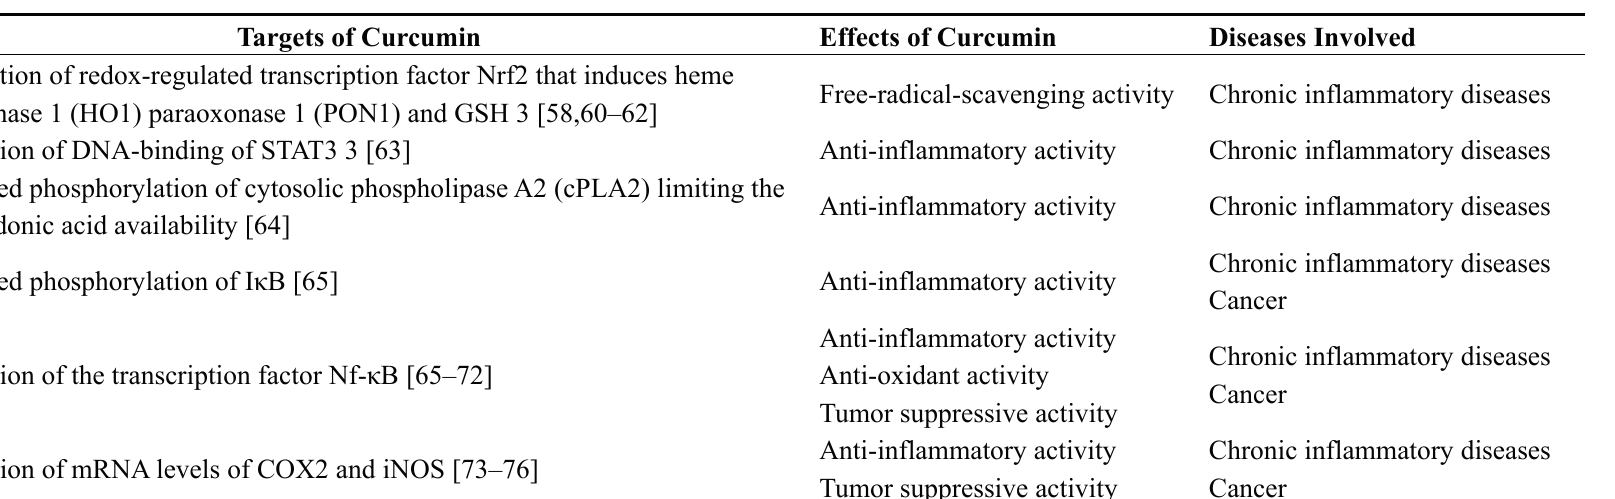
Table 3. Molecular targets of curcumin and relative effects and diseases